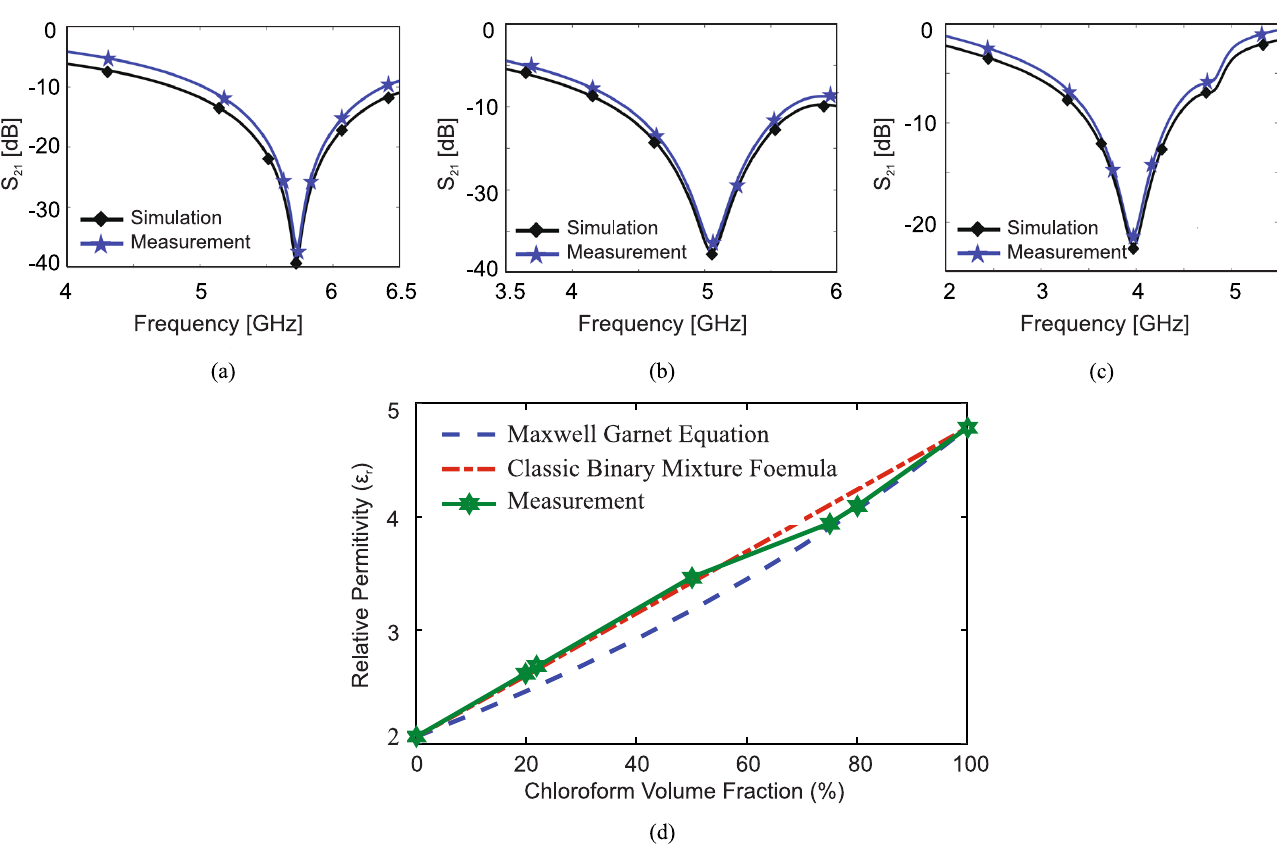
Figure 22. Comparisons between the simulated and measured | S 21 | of the sensor when it is unloaded ( a ) and is loaded with cyclohexane ( b ) and chloroform ( c ); ( d ) the dielectric constant of the mixture of chloroform and cyclohexane as a function of the volume fraction of chloroform. Reprinted with permission from Ref.